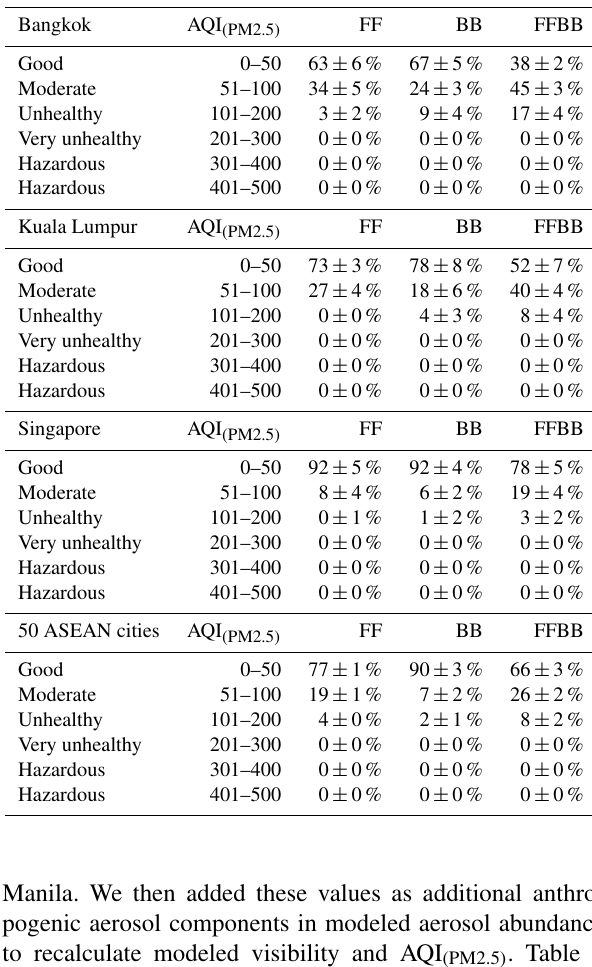
Table 4. Same as Table 3 but using 24h PM 2 . 5